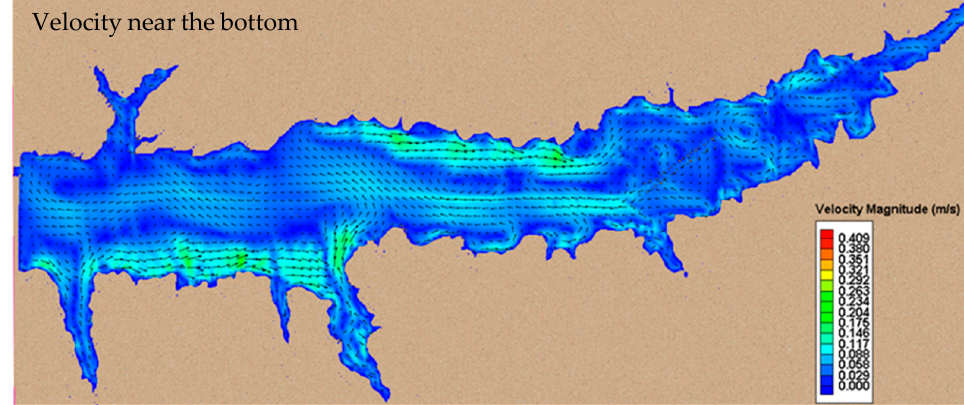
Figure 7. Simulated flow patterns at the water surface of Enid Lake.